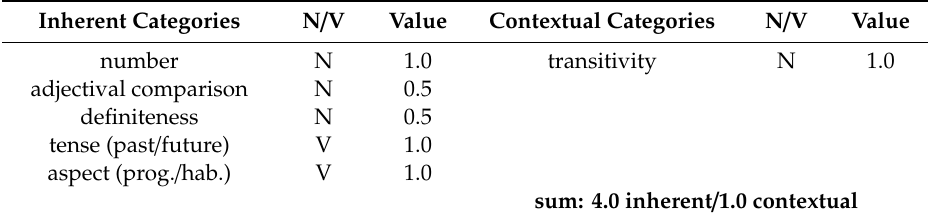
Table 6. The grammatical categories of Tok